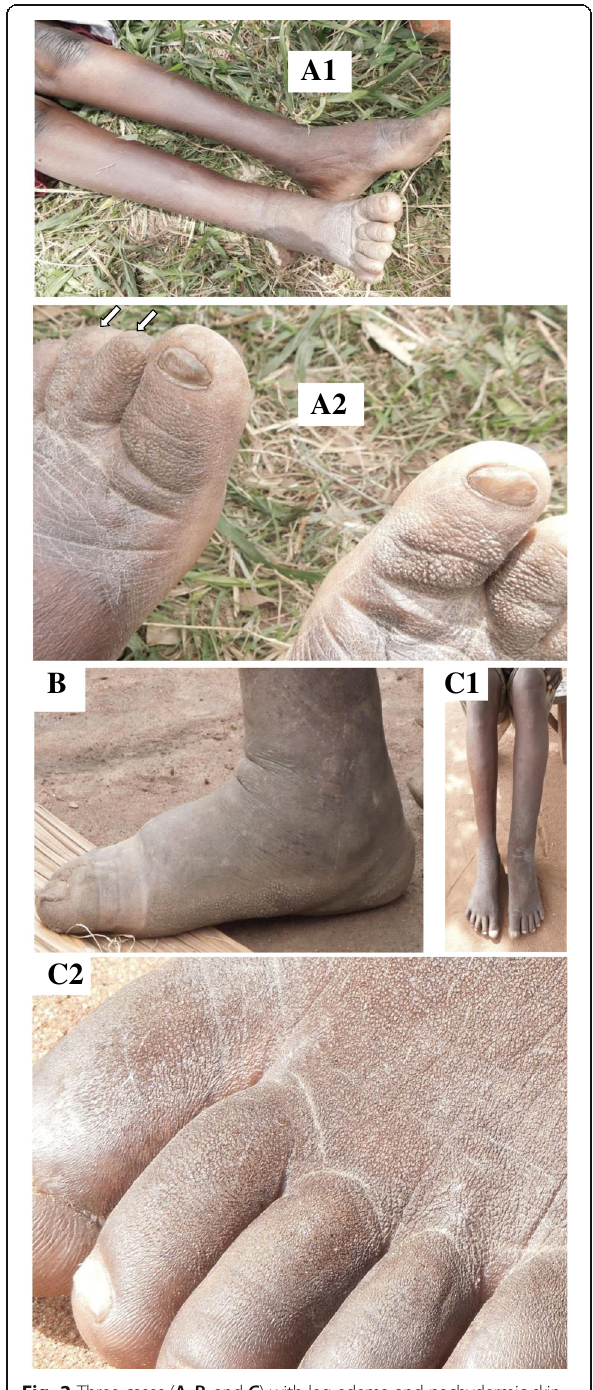
Fig. 2 Three cases ( A , B , and C ) with leg edema and pachydermic skin changes. In case A , the right lower leg is slightly edematous and the dorsal skin of the right foot is whitish in appearance ( A1 ). The skin of the foot is pachydermic and mossy: the skins of the right toes are rather spiny, and the nails of the left 2nd and 3rd toes are unrecognizable ( arrows ) ( A2 ). In case B , foot edema and pachydermic skin change along the side of the foot are recognized ( B ). Mild edema is observable in the left lower leg of case C ( C1 ), and the skin around the left toes is pachydermic ( C2